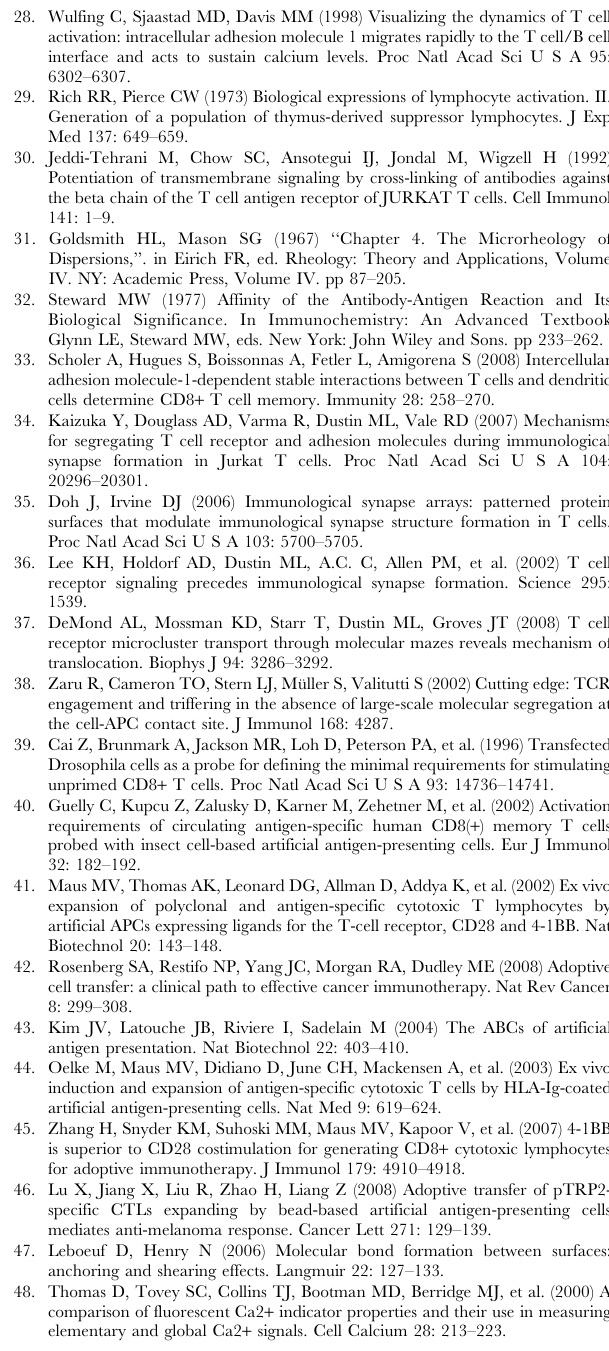
Figure S4 Cell-particle contact area: The contact area was assumed to form a spherical cap with a solid angle of a on the bead. a was estimated on microscope images - we show here a representative example - and contact area was taken equal to 2 p rb2(1-cos a